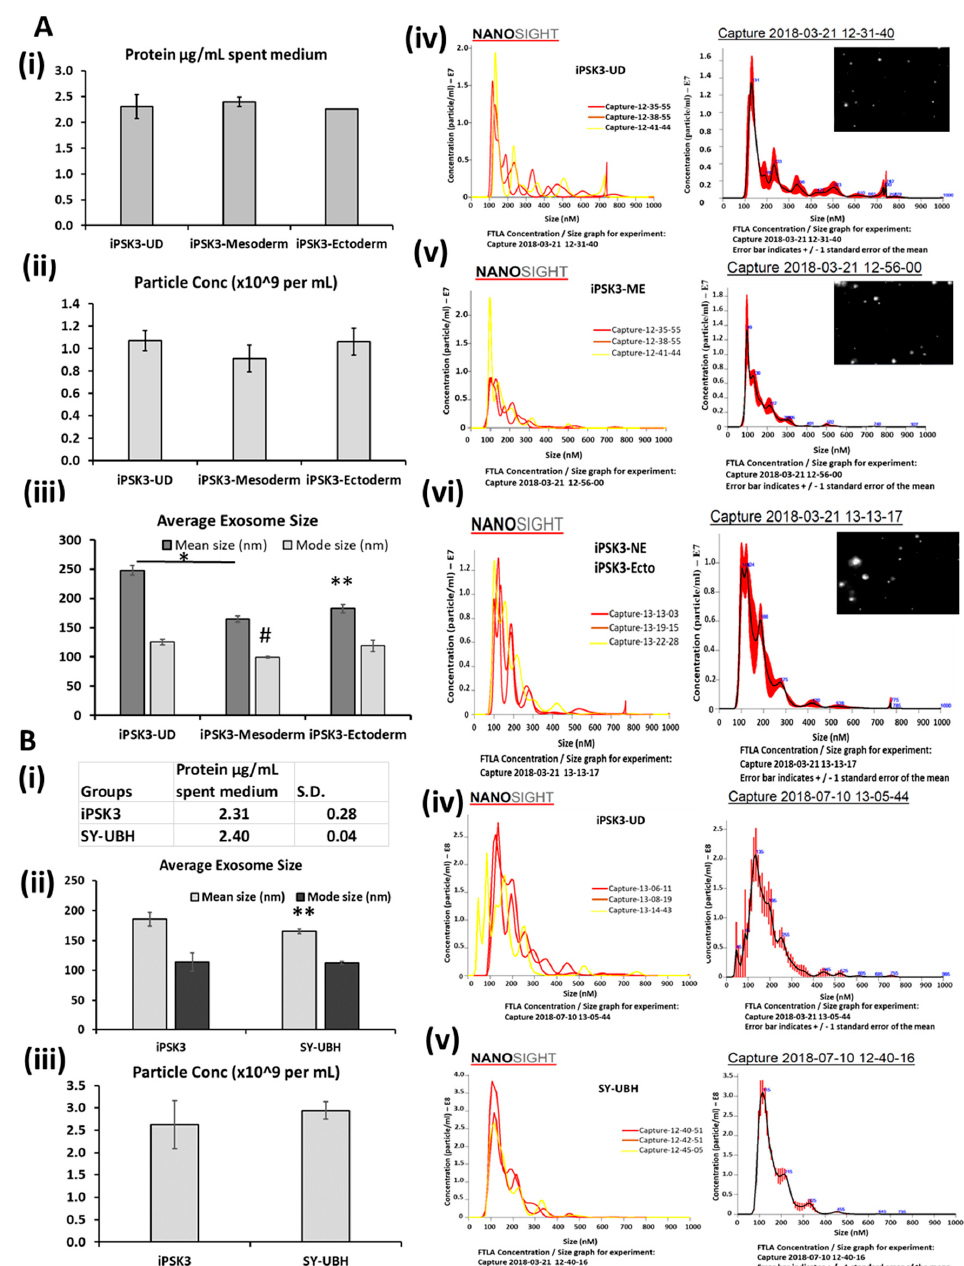
Figure 2. Characterization of hiPSC-derived EVs by nanoparticle tracking analysis (NTA). ( A ) Comparison of EVs from undifferentiated, mesoderm, and ectoderm (i.e., NPC) cultures derived from iPSK3 cells: (i) protein content per mL spent medium; the error for the iPSK3-ectoderm group is very small/zero; (ii) particle concentration. Particles were in 1 mL of particle-free phosphate buffer saline (PBS), which originated from 12 mL of spent media; (iii) mean and mode average particle size. Representative NTA histogram for (iv) undifferentiated; (v) mesoderm; (vi) ectoderm. The insets show the representative light scattering images. ( B ) Comparison of EVs from undifferentiated iPSK3 cells and SY-UBH cells: (i) protein content per mL spent medium; (ii) particle concentration. Particles were in 1 mL of particle-free PBS, which originated from 22 mL of spent media. (iii) Mean and mode average particle size. Representative NTA histogram for (iv) iPSK3 cells and (v) SY-UBH cells. * and ** indicate p < 0.05 for mean size, and # indicates p < 0.05 for the mode size between the compared conditions and the undi ff erentiated iPSK3 group ( n =